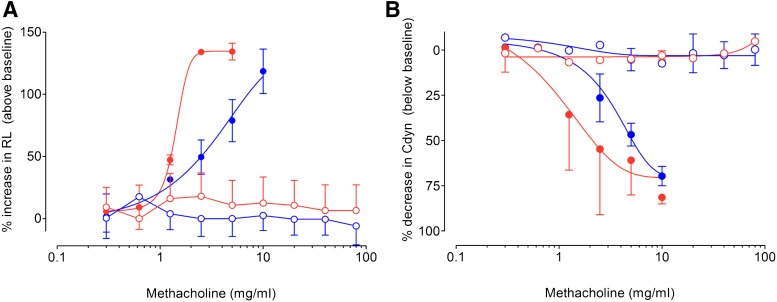
Cumulative dose-response curves to aerosolized methacholine in the absence of (closed symbols) or following treatment with muscarinic antagonists (open symbols), tiotropium bromide (A and B), in rabbits exposed to air (blue symbol) or ozone (red symbol). Data are expressed as the mean ± S.D. of percentage increase in baseline RL (A) or percentage decrease in baseline Cdyn (B). For the purposes of visualization of the data, the untreated mean curves are duplicated in each panel.